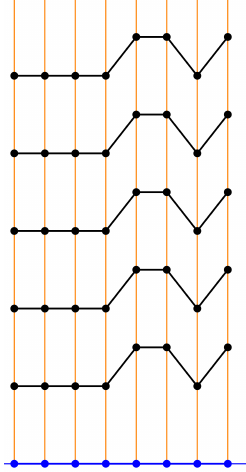
Figure 9. Some of the infinite number of similar sections to that of the fourth section in the set for p = 4 of L ( C ( 3 ) ; z ) (bottom set in Figure 8). This forms the equivalence class ˆ σ 3 .